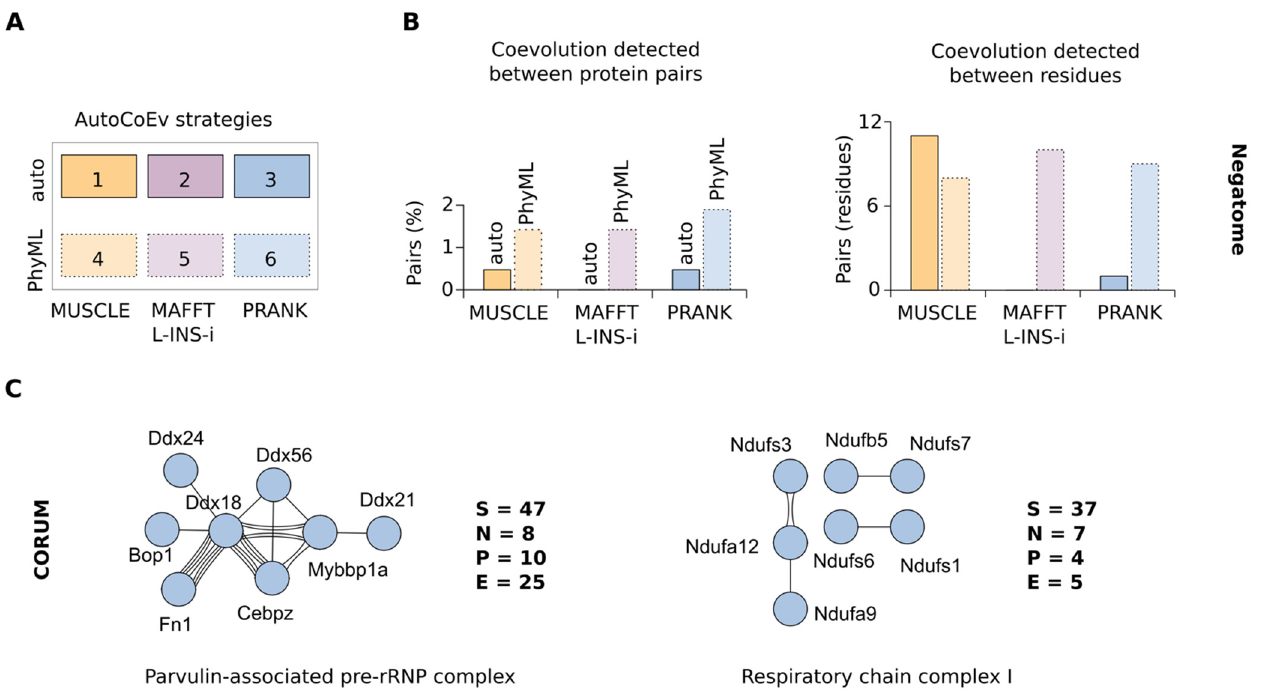
Figure 2. Determining the strategy of the AutoCoEv analysis. ( A ) Strategies. Combinations of MSA method and phylogenetic trees calculation methods, 1–6, are referred as “strategies”. ( B ) The Negatome database was analysed by AutoCoEv. Percentage of the protein pairs for which coevolution was detected (left) and the total number of coevolving amino acid sites (right). ( C ) CORUM database complexes were analysed by AutoCoEv. Coevolution was detected in five out of the first ten complexes. Shown are the two largest complexes. S: number of complex subunits (found in OrthoDB); N: number of nodes in the network; P: protein pairs detected; E: number of edges (total number of coevolving amino acids).